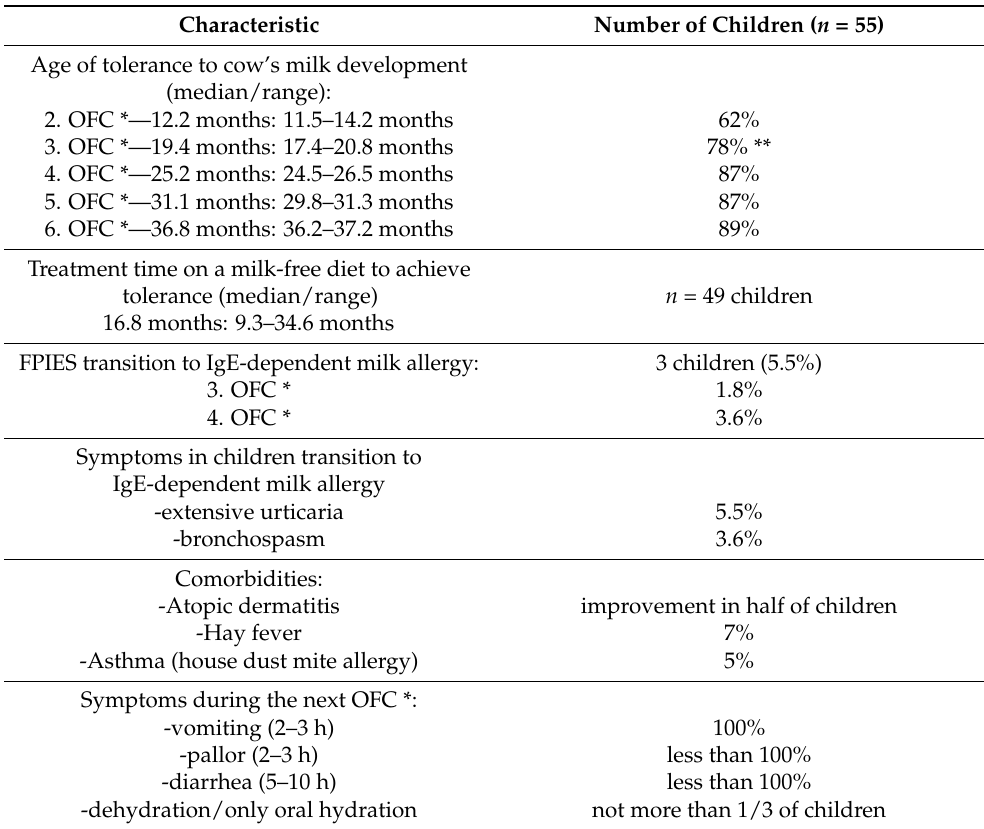
Table 2. Natural history of chronic food protein-induced enterocolitis syndrome (FPIES) dependent on cow’s milk protein intake in the study group of